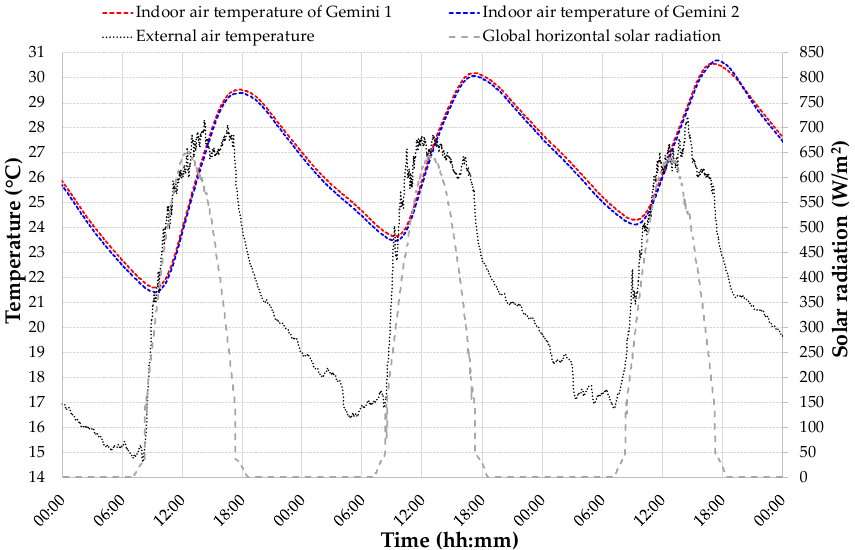
Figure 3. Gemini 1 and Gemini 2 preliminary experimental indoor air temperature trends for three typical June days.